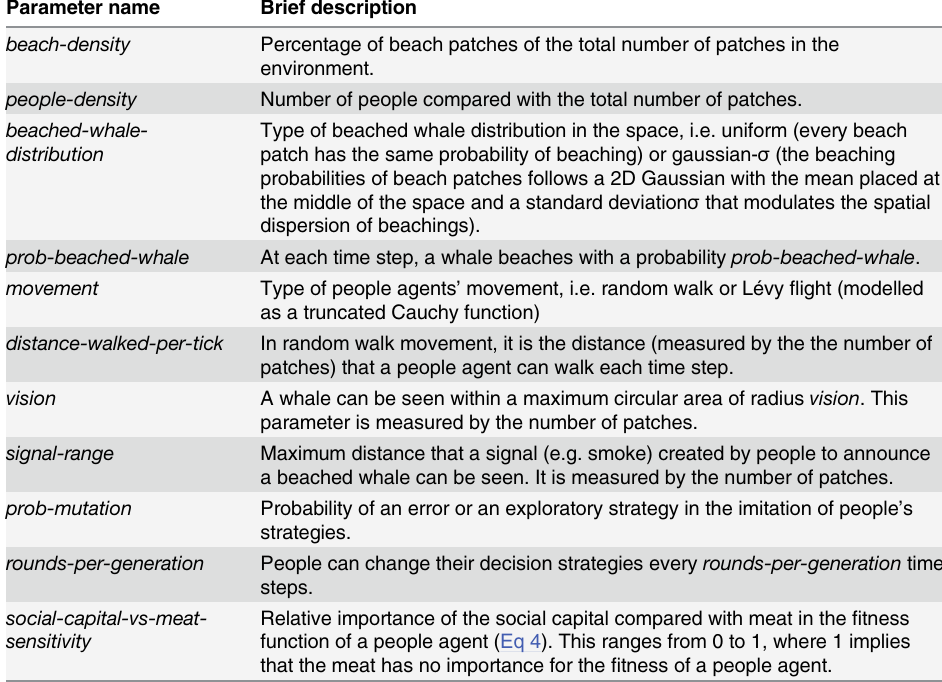
Table 1. Study parameters.